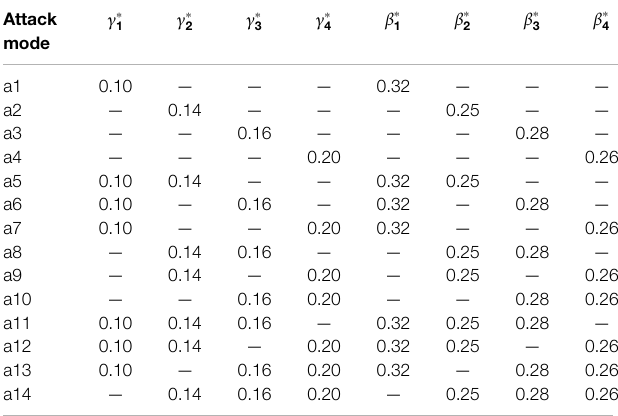
TABLE 5 | Optimal values under different attack modes. Attack mode